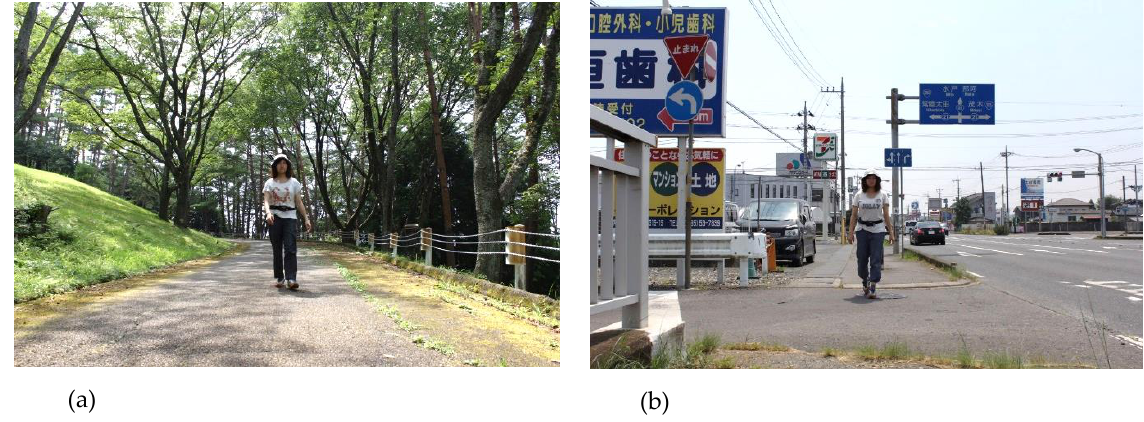
Figure 1. Walking through forest ( a ) and city ( b ) areas.